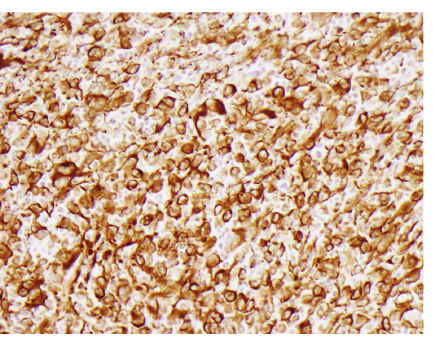
Figure 6: Immunohistochemistry demonstrating tumour cells staining for vimentin (Vimentin ×